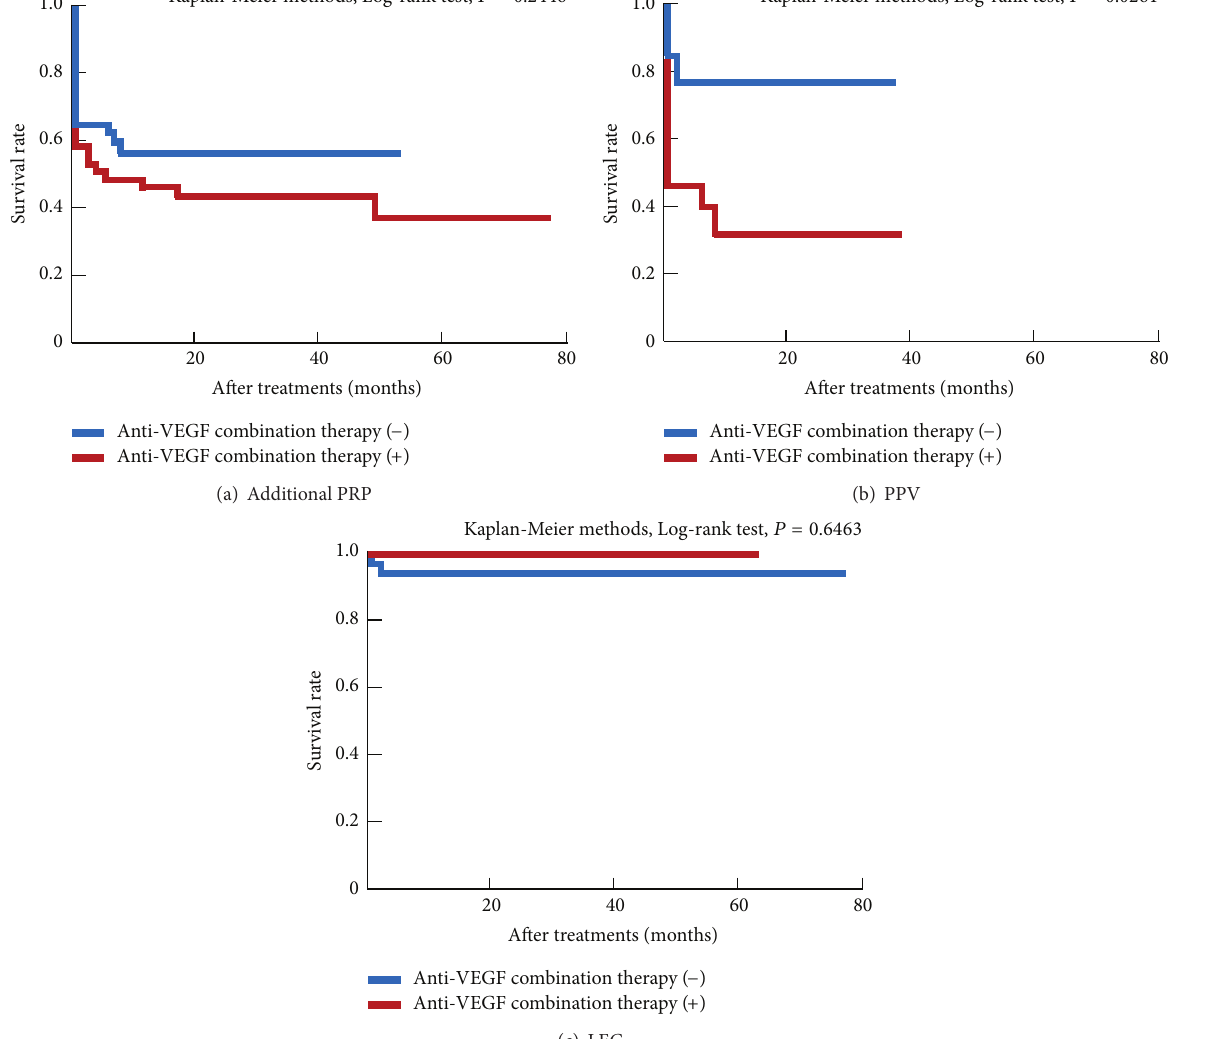
Figure 7: Long-term prognosis of each treatment with or without anti-VEGF combination therapy (univariate analysis). Anti-VEGF combination therapy had no positive impact on long-term